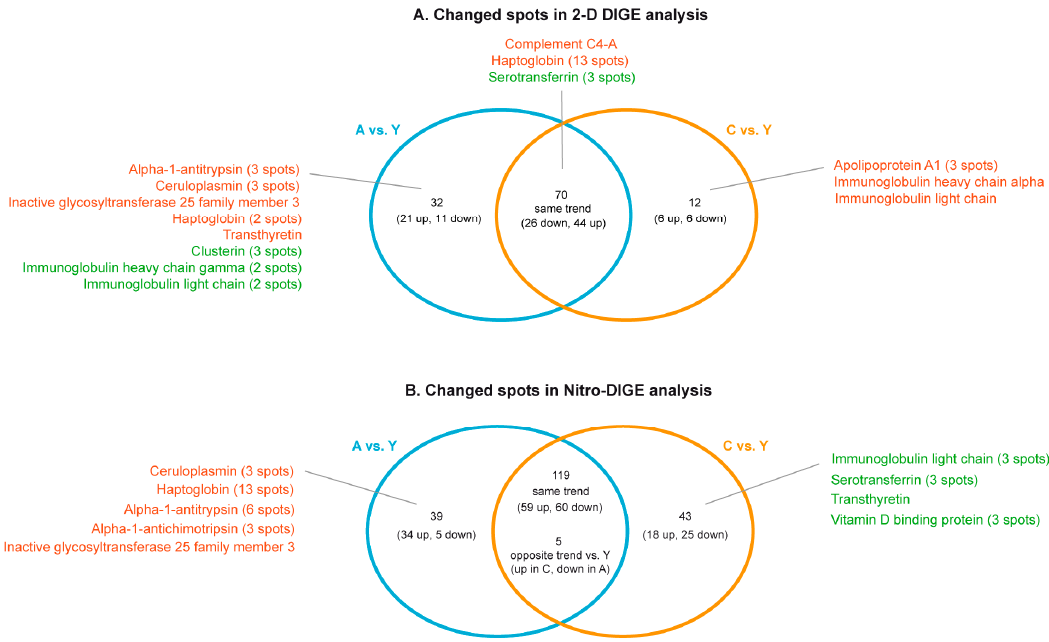
Figure 2. Schematic diagrams resuming findings obtained from two-dimensional di ff erential in gel electrophoresis (2-D DIGE) ( A ) and Nitro-DIGE ( B ) proteomic analyses conducted on albumin-depleted sera from young (Y), aged (A), and centenarian (C) women. Protein names and number of identified spots (corresponding to di ff erent proteoforms) were reported (red = increased; green = decreased levels in A and / or C vs. Y, ANOVA and Tukey, n = 6 (2-D DIGE) or n = 9 (Nitro-DIGE), p -value <